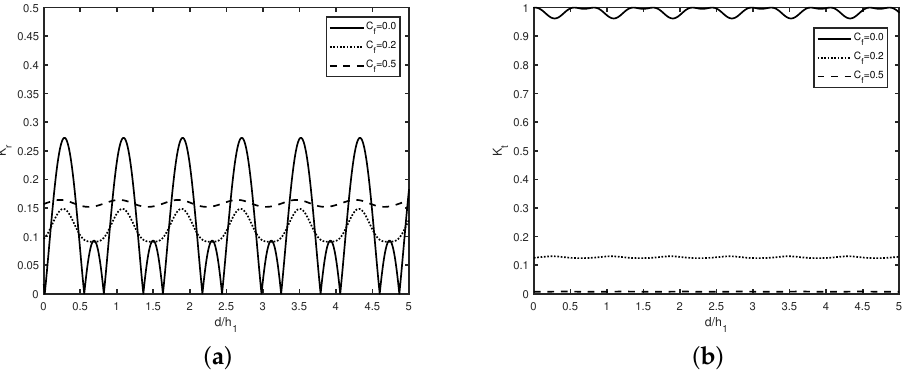
Figure 11. Variation of ( a ) reflection coefficient K r , and ( b ) transmission coefficient K t versus gap d / h 1 for different values of C f with breakwater width w / h 1 = 1.0, h 2 / h 1 = 0.5 and N =